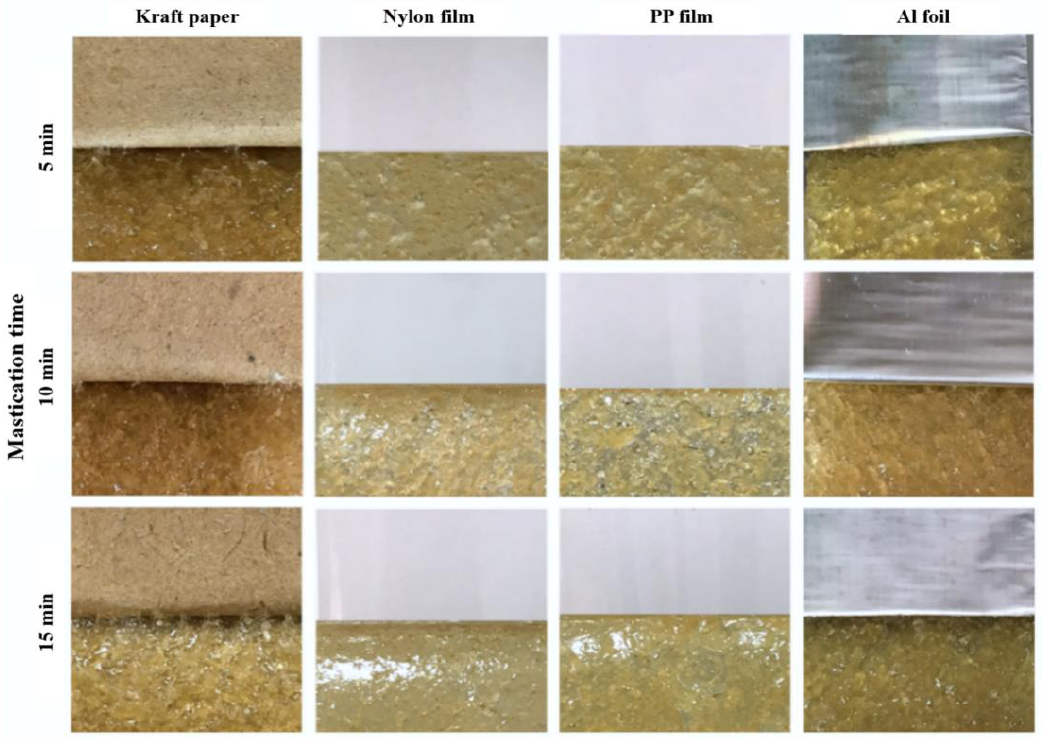
Figure 5. Physical appearance of NR-PSA/CO produced with 20 phr of XG + 0.06 phr of CO by using 2 mm nip gap with different mastication time (5–15 min). Table 3. Peel and shear strengths of NR-PSA/CO produced with 20 phr of XG + 0.06 phr of CO by using a two-roll mill mixer with a nip gap of 2 mm at various mastication time (5–15